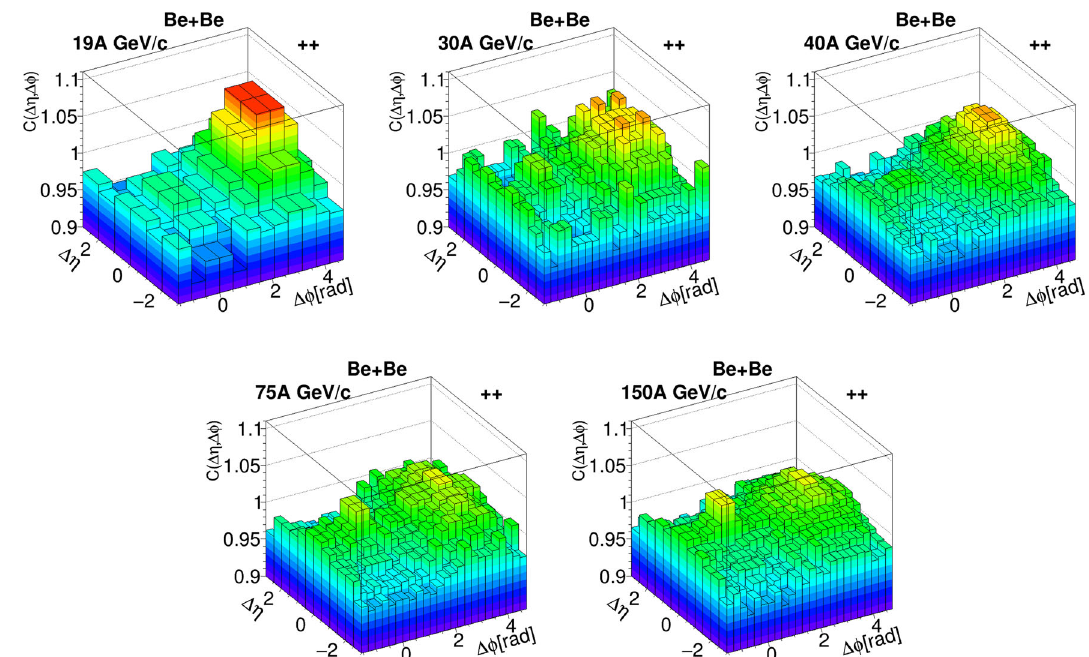
Fig. 8 Two-particle correlation function C ((cid:2)η,(cid:2)φ) for positive charge pairs in the 5% most central Be + Be collisions at 19 A –150 A GeV / c